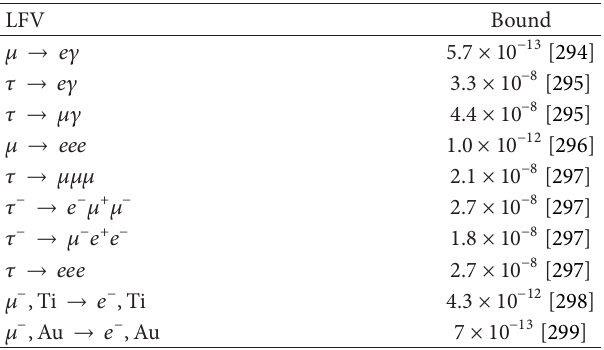
Table 8: Current experimental bounds for some low-energy LFV